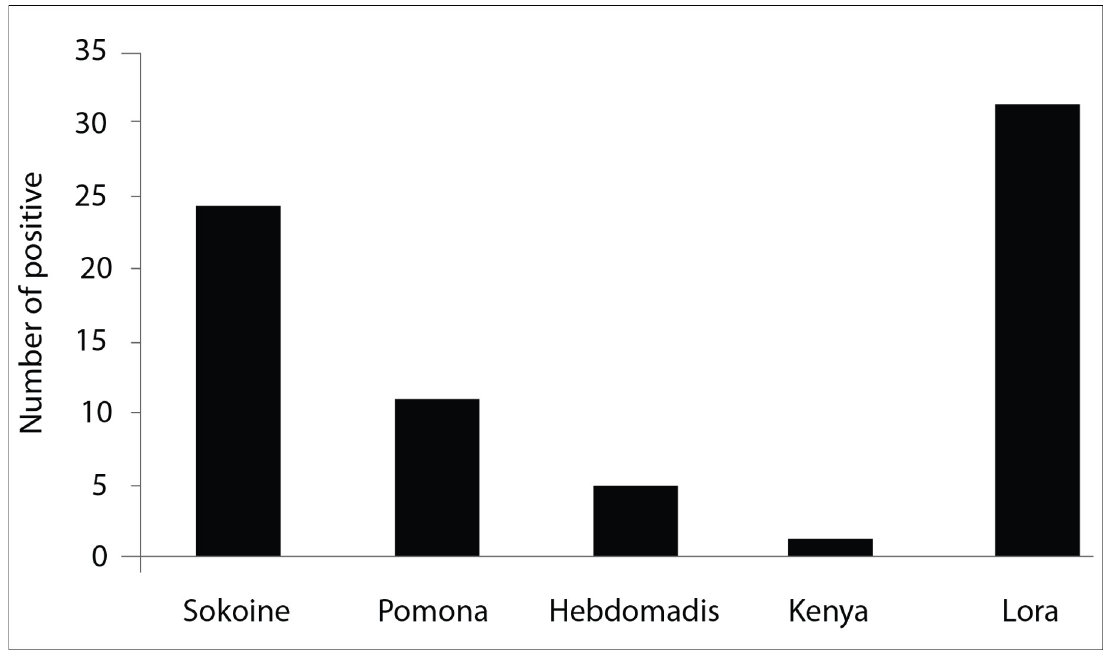
Fig 2. Antibodies against Leptospira serovars detected in